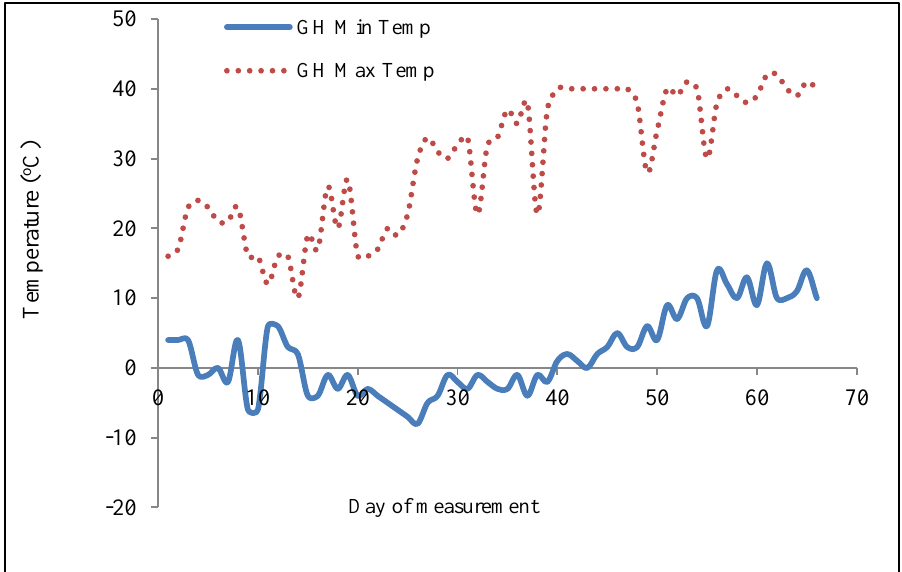
Figure 1. Minimum and maximum temperature in the greenhouse with respect to day of measurement. GH: Greenhouse.